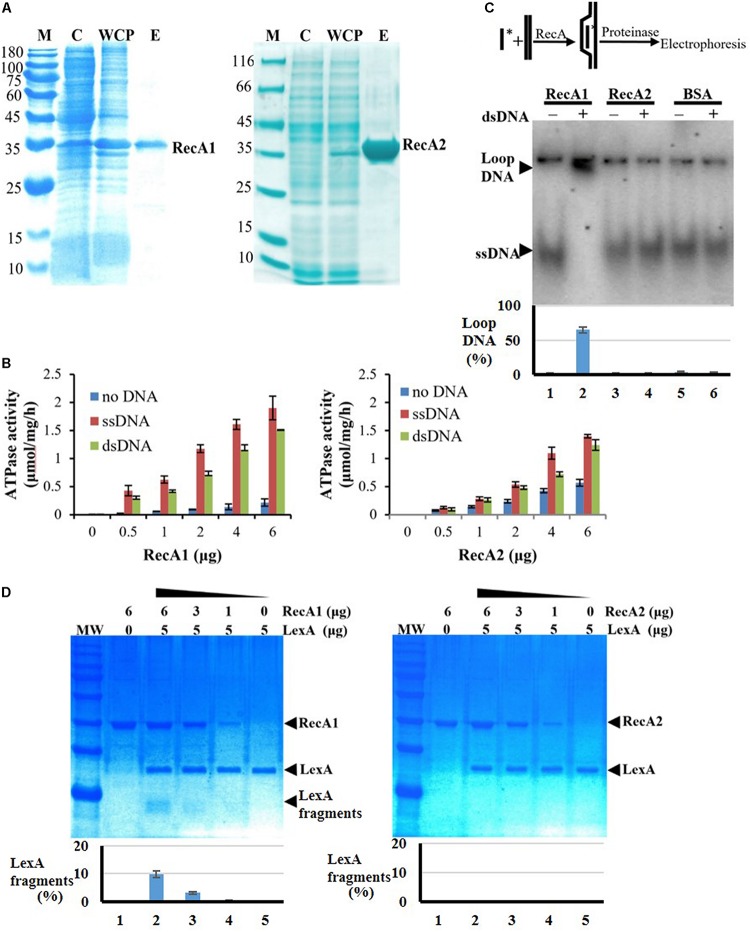
Expression and activity analysis of RecA proteins. (A) Expression and purification of RecA1 and RecA2. M, marker; C, control; WCP, whole-cell protein; E, eluent of purified protein. (B) Assays of ATPase activities. The ATPase activity was determined by measuring free phosphate ion (Pi) released from enzymolysis of ATP. The error bar is calculated from three independent repeats. (C) D-loop assay. A 60-nt 32P-labeled ssDNA fragment and a superhelical dsDNA (RF M13) sequence were mixed and incubated with and without the addition of purified RecA1 or RecA2 proteins. If the protein has HR activity, the homologous pairing reaction will be initiated, thus forming the ssDNA–dsDNA complex. Bovine serum albumin (BSA) was used as a control. Relative DNA-labeled intensities of the bands were quantified by a Gel-Doc image analysis system (Bio-Rad). The percentage of loop-DNA-labeled intensity in the total labeled intensity (including the labeled strength in ssDNA, loop-DNA, and residual DNA in the origin) was used to quantitate the RecA activity. (D) The promotion ability of RecA1 (left) or RecA2 (right) on the cleavage of LexA proteins. The MxLexA protein was incubated with gradient concentrations of RecA1 or RecA2 proteins in the presence of ssDNA and ATP. Reactions were stopped and visualized on a 1.2% SDS-PAGE gel stained with Coomassie brilliant blue. The bands were quantified by computerized image analysis (Bio-Rad), and the percentage of LexA fragments in the total LexA signal in every lane was used to quantify the ability of RecA to stimulate LexA autocleavage.